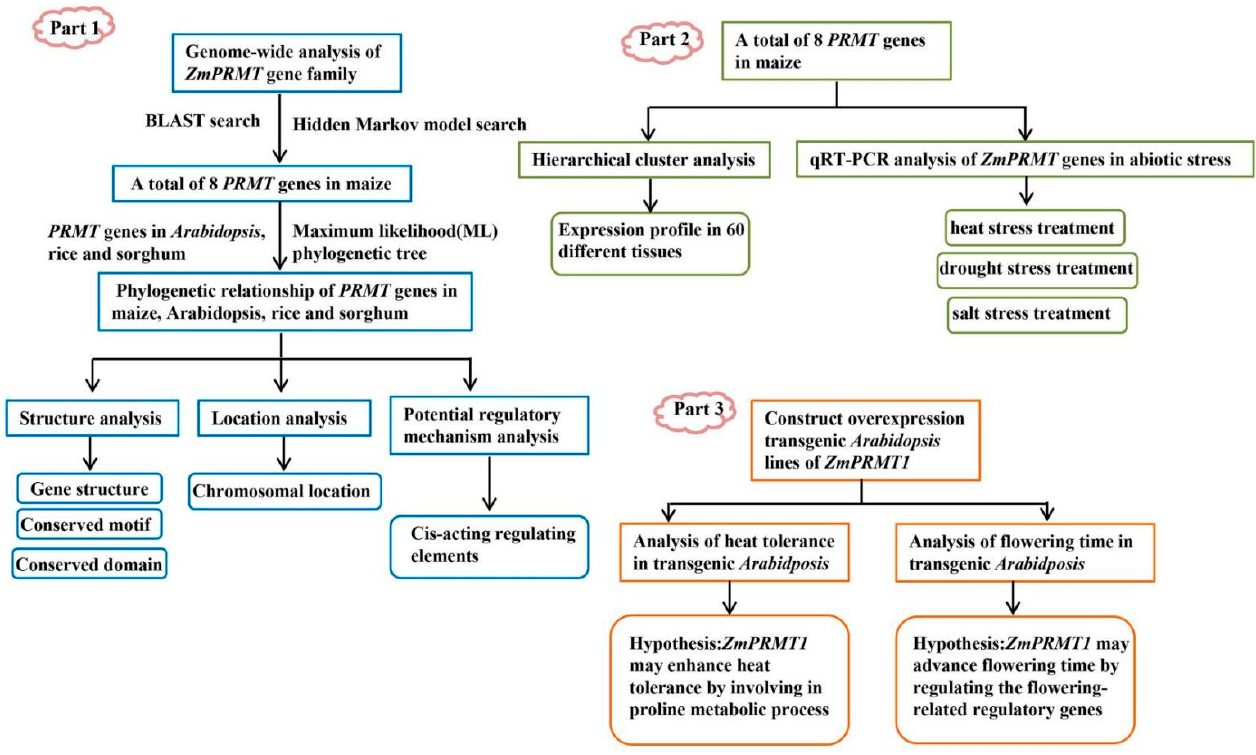
Figure 14. The schematic flowchart of the study.